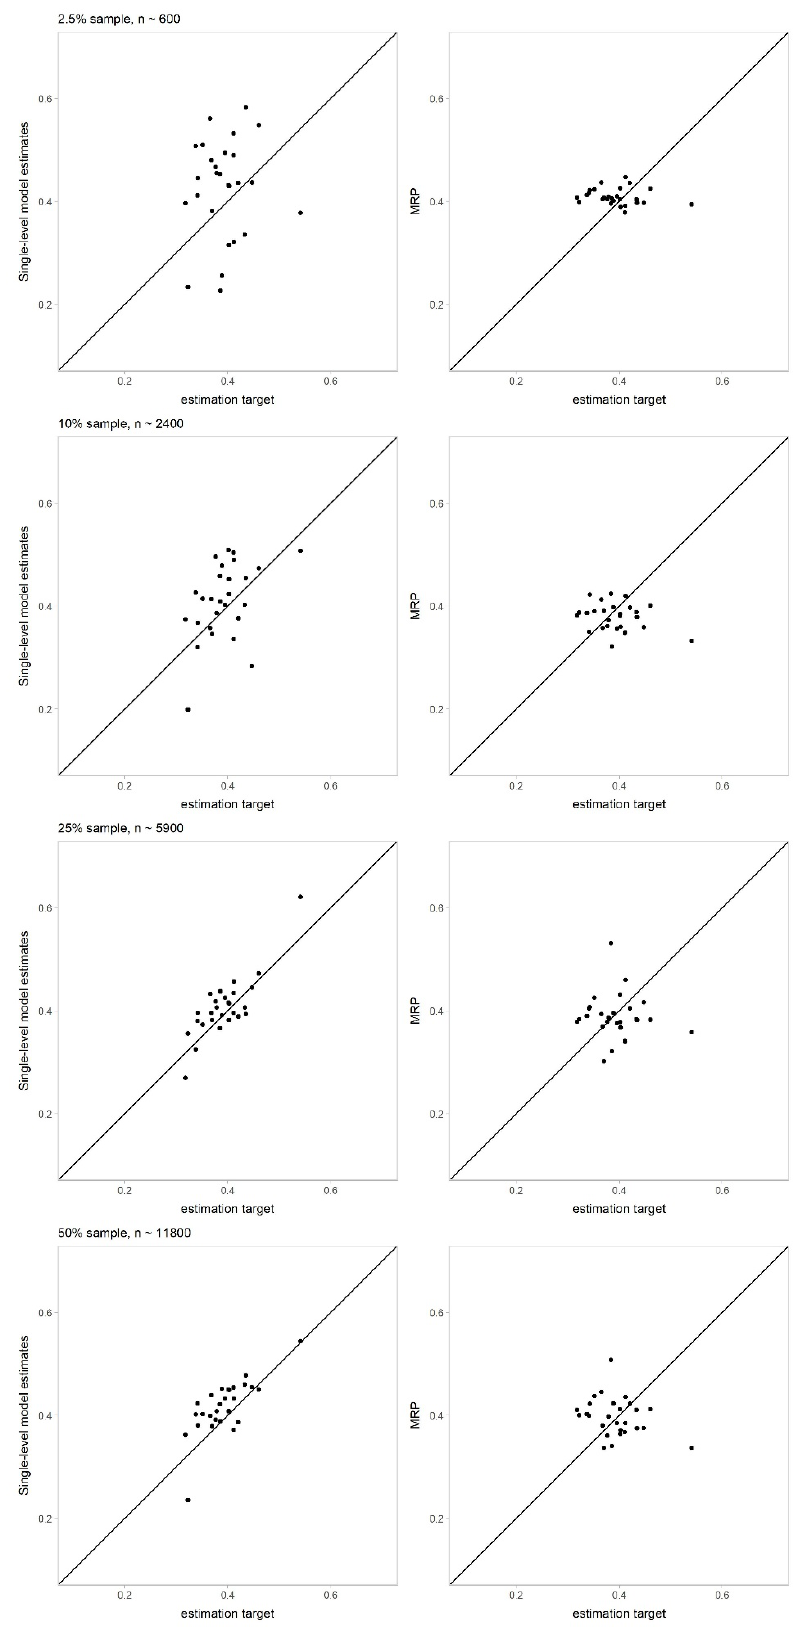
Figure 3. Plotted MRP and single-level regression estimates against estimation target (“true value”) by subsample size.